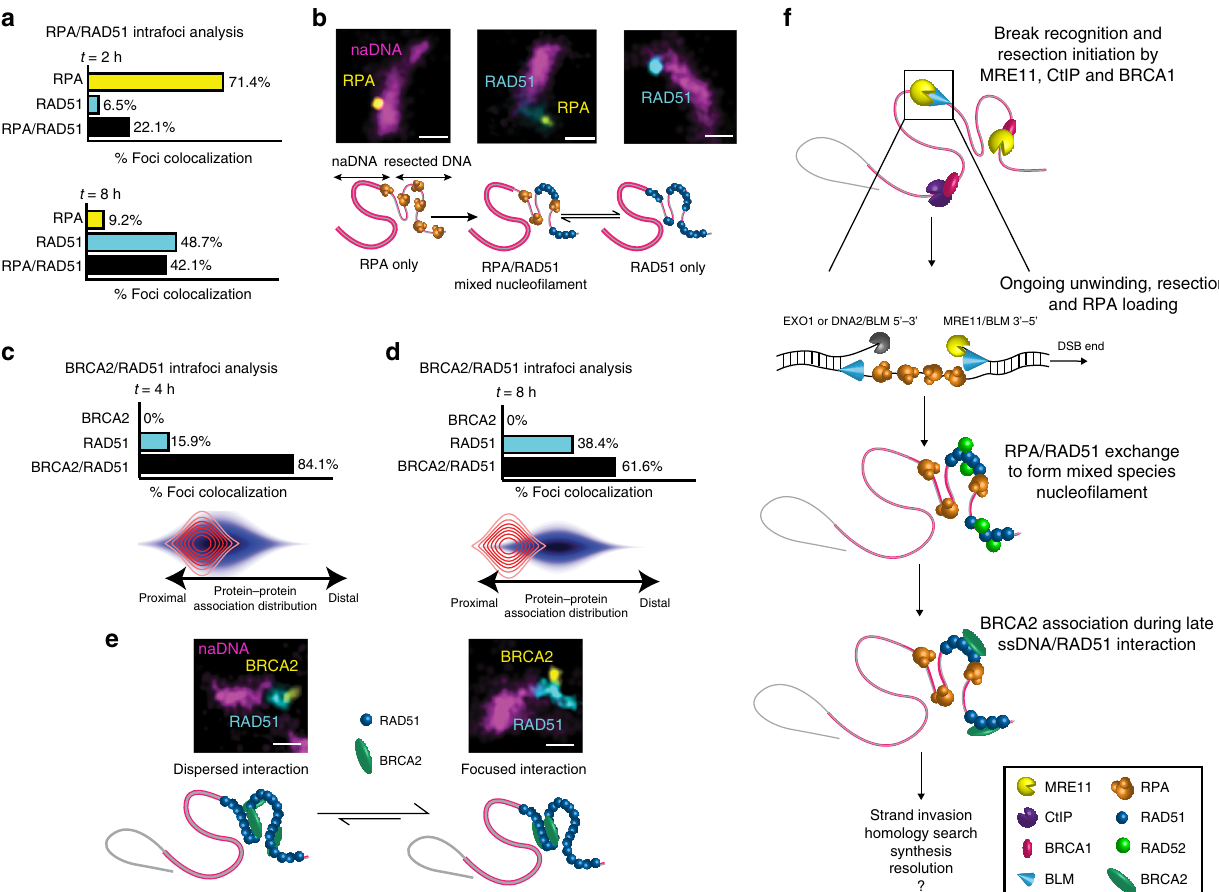
Fig. 3 RPA dynamically exchanges with RAD51 within the nucleo fi lament while BRCA2 localizes to RAD51 subpopulations. a Analysis of the colocalization of RPA and RAD51 at repair foci 2 and 8 h after damage. b Model depicting the observed initial predominance of RPA-only foci before a later transition to equilibrium between mixed RPA/RAD51 and RAD51-only foci. Representative foci shown (scale bar = 250 nm). c , d Analysis of the colocalization and internal distribution of BRCA2 and RAD51 at repair foci 4 and 8 h after damage. e Model depicting earlier dispersed interaction between BRCA2 and the ssDNA/RAD51 nucleo fi lament and later focused interactions. Representative foci shown (scale bar = 250 nm). f A model showing the spatiotemporal associations and interactions of key proteins involved in HR repair of seDSBs, speci fi cally the progression from resection to RPA exchange with RAD51/ RAD52, and fi nally BRCA2 association. For complete N values, see Supplementary Tables 1,